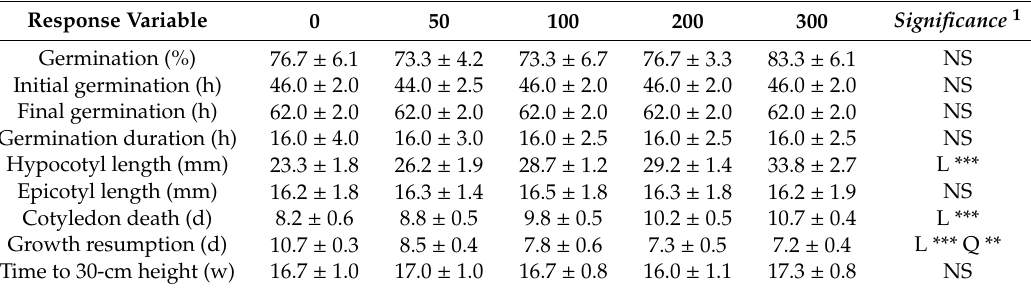
Table 4. The influence of imbibing Serianthes nelsonii seeds with gibberellic acid (mg / L GA 3 ) on germination in darkness and seedling traits. Mean ± standard error. Six replications, five seeds